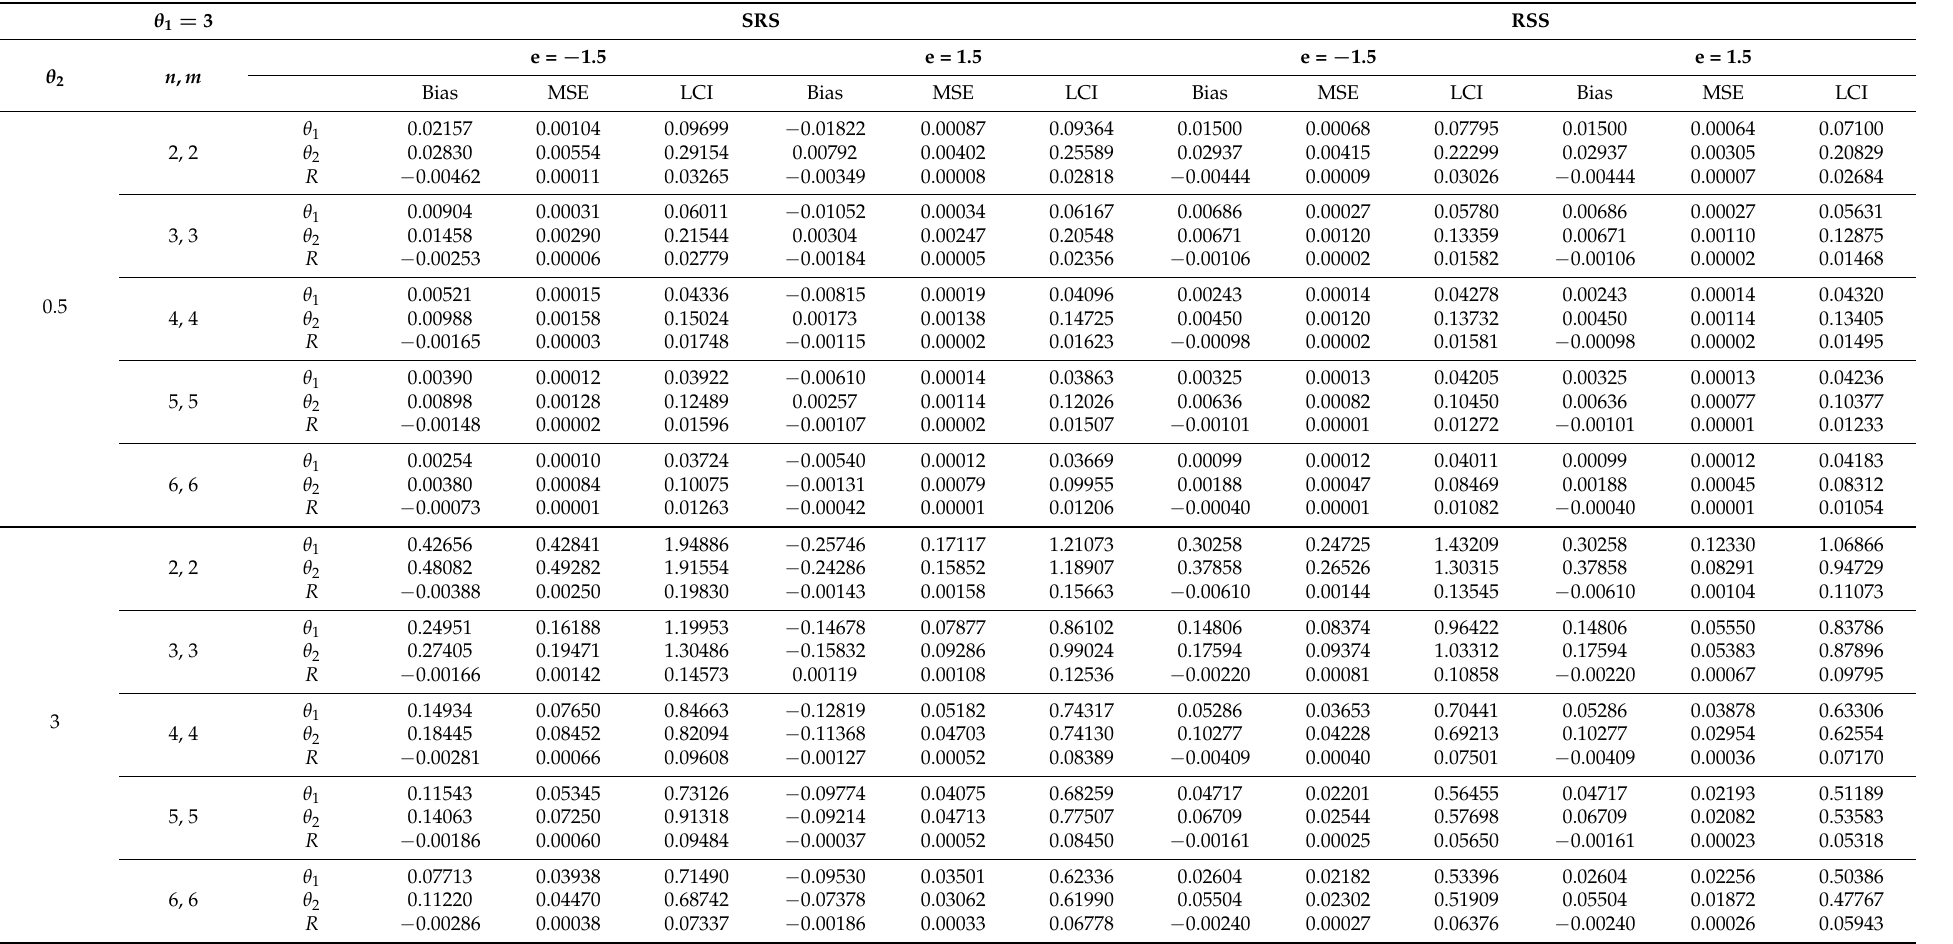
Table 5. SRS and RSS by Bayesian Method with Gamma Prior under LINEX Loss Function of Parameters and R of ITL Stress Strength Model θ 1 =